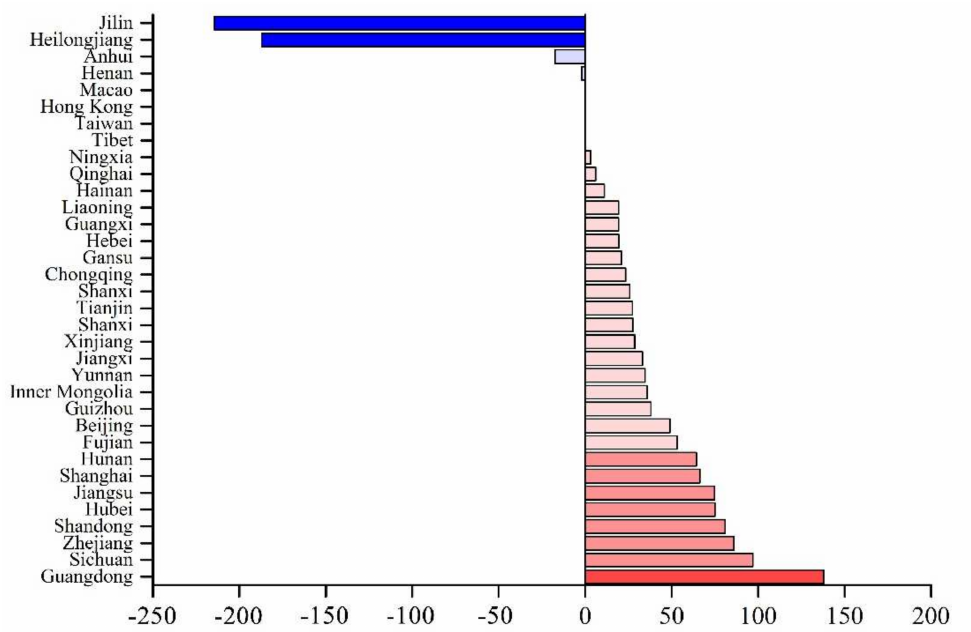
Figure 5. Provincial market gap in China. Note: The blue color means that the value of the market gap is negative, that is, bioethanol is overproduced. The red color means that the value of the market gap is positive, that is, bioethanol production cannot meet the market